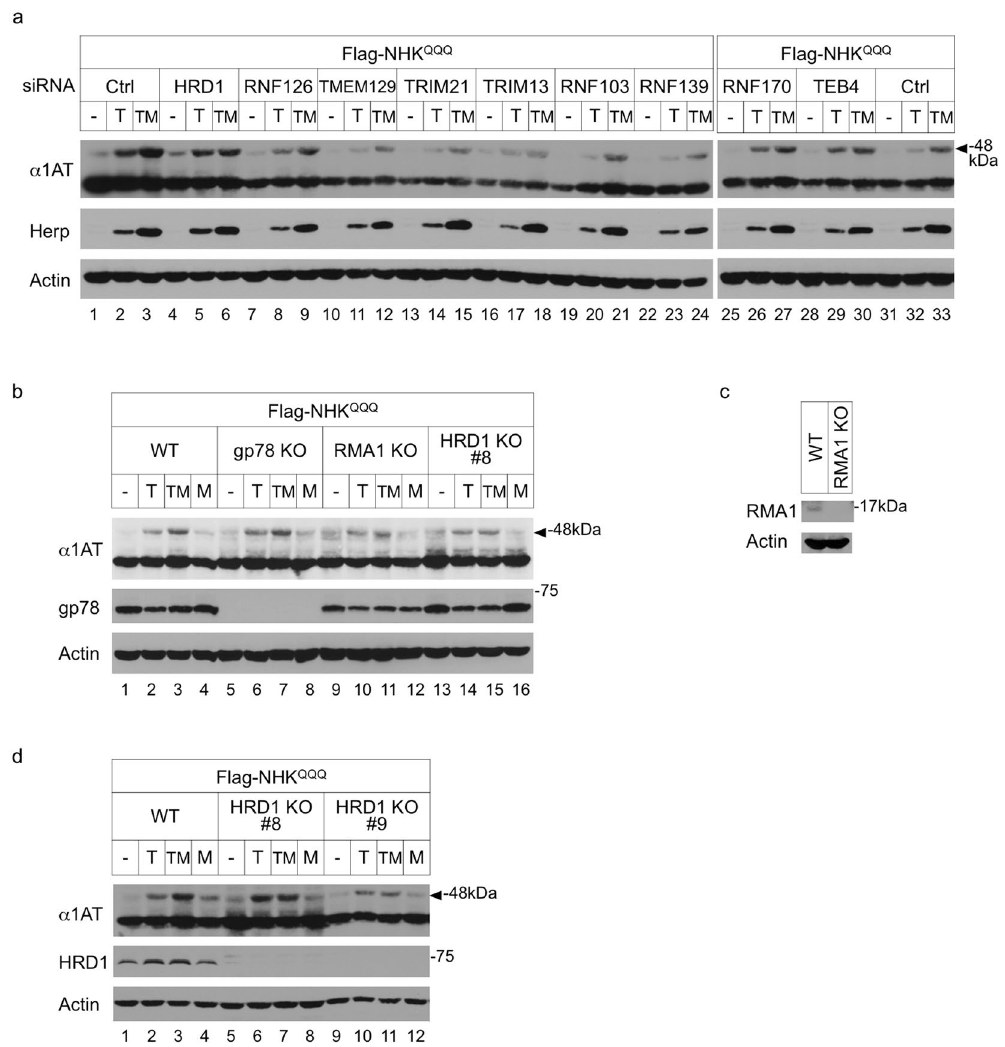
Figure 2. HRD1 is required for the proteasomal degradation of ERpQC substrates. ( a ) The effects of knockdown of ERAD-related and Bag6-related E3 ligases on the accumulation of ERpQC substrates. To clearly distinguish the size of ERpQC substrates from that of ERAD substrates, N-terminal Flag-tagged NHK QQQ (Flag-NHK QQQ ) was used as the ERpQC substrate. HEK293 cells were transfected with siRNA against control (Ctrl) or each E3 ligase and treated with the indicated combinations for 16 h after transfection with Flag- NHK QQQ -HA. Cell lysates were analyzed by IB. Arrowhead indicates S NHK QQQ . T, 50 nM Tg; TM, 50 nM Tg and 200 nM MG132. ( b – d ) Deletion of HRD1 enhances the accumulation of ERpQC substrates in the absence of a proteasome inhibitor. WT, gp78 KO, RMA1 KO, or HRD1 KO (clone #8 or #9) HEK293 cells transfected with Flag-NHK QQQ -HA were treated with the indicated combinations and analyzed by IB. Deletion of HRD1 ( d ), gp78 ( b ), or RMA1 ( c ) was confirmed by IB using Ab against HRD1, gp78 or RMA1, respectively. Arrowheads indicate S NHK QQQ . T, 50 nM Tg; TM, 50 nM Tg and 200 nM MG132. ( a – d ) Full-length blots are presented in Supplementary Fig.